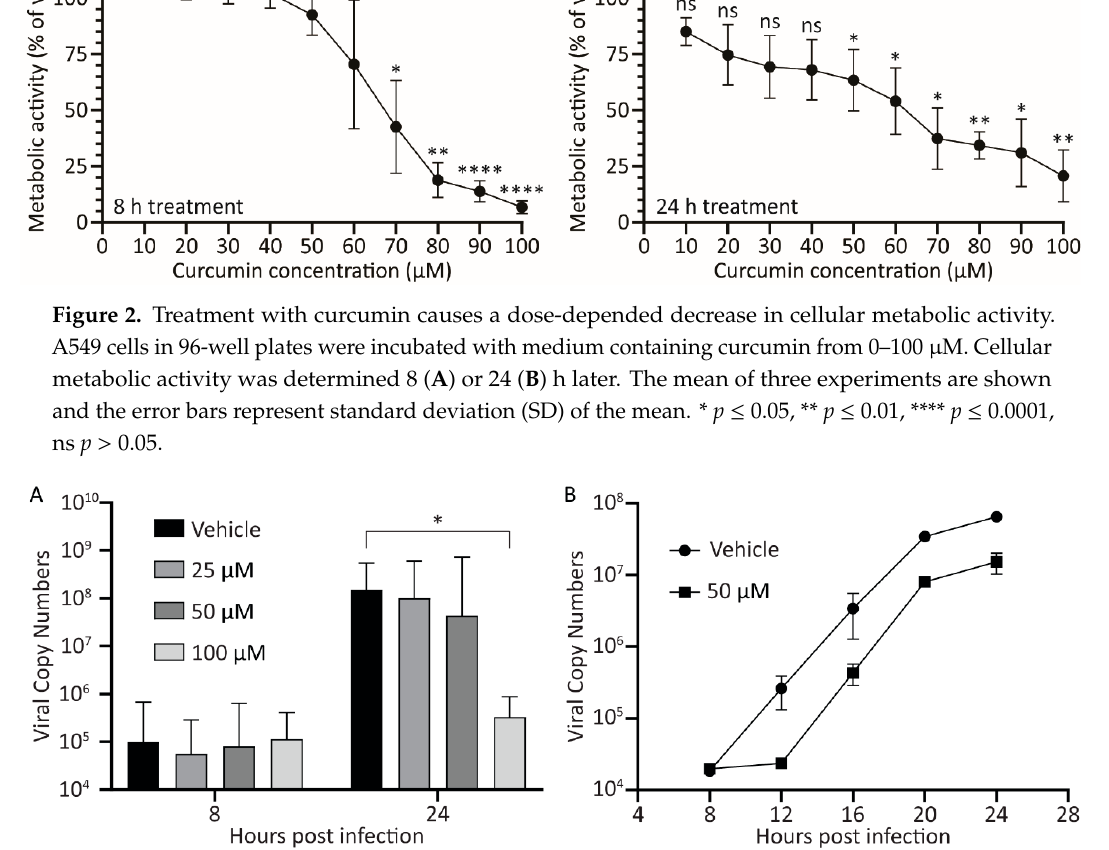
Figure 3. Treatment with curcumin reduces HAdV-5 genome copy number within cells. ( A ) A549 cells were infected with HAdV-5 at an MOI of 10 and overlaid with medium containing curcumin (0, 25, 50, and 100 µM). At 8 and 24 hpi, total DNA was isolated from the cells by sodium dodecyl sulphate (SDS)-proteinase K digestion and phenol/chloroform extraction. The resulting DNA was subjected to qPCR to determine the average genome copy number per 200 ng DNA, normalized to the average copy number of human GAPDH. The mean of three experiments are shown and the error bars represent standard deviation (SD) of the mean. ( B ) A549 cells were infected with HAdV-5 at an MOI of 10 and overlaid with medium containing curcumin (0 and 50 µM). Eight hpi and every 4 h until 24 hpi, total DNA was isolated from the cells by SDS-proteinase K digestion and phenol/chloroform extraction. The resulting DNA was subjected to qPCR to determine the average genome copy number per 200 ng DNA, normalized by average copy number of human GAPDH. Data represents a single experiment analyzed in duplicate, with error bars representing standard deviation (SD) of the mean. * p ≤ 0.05.